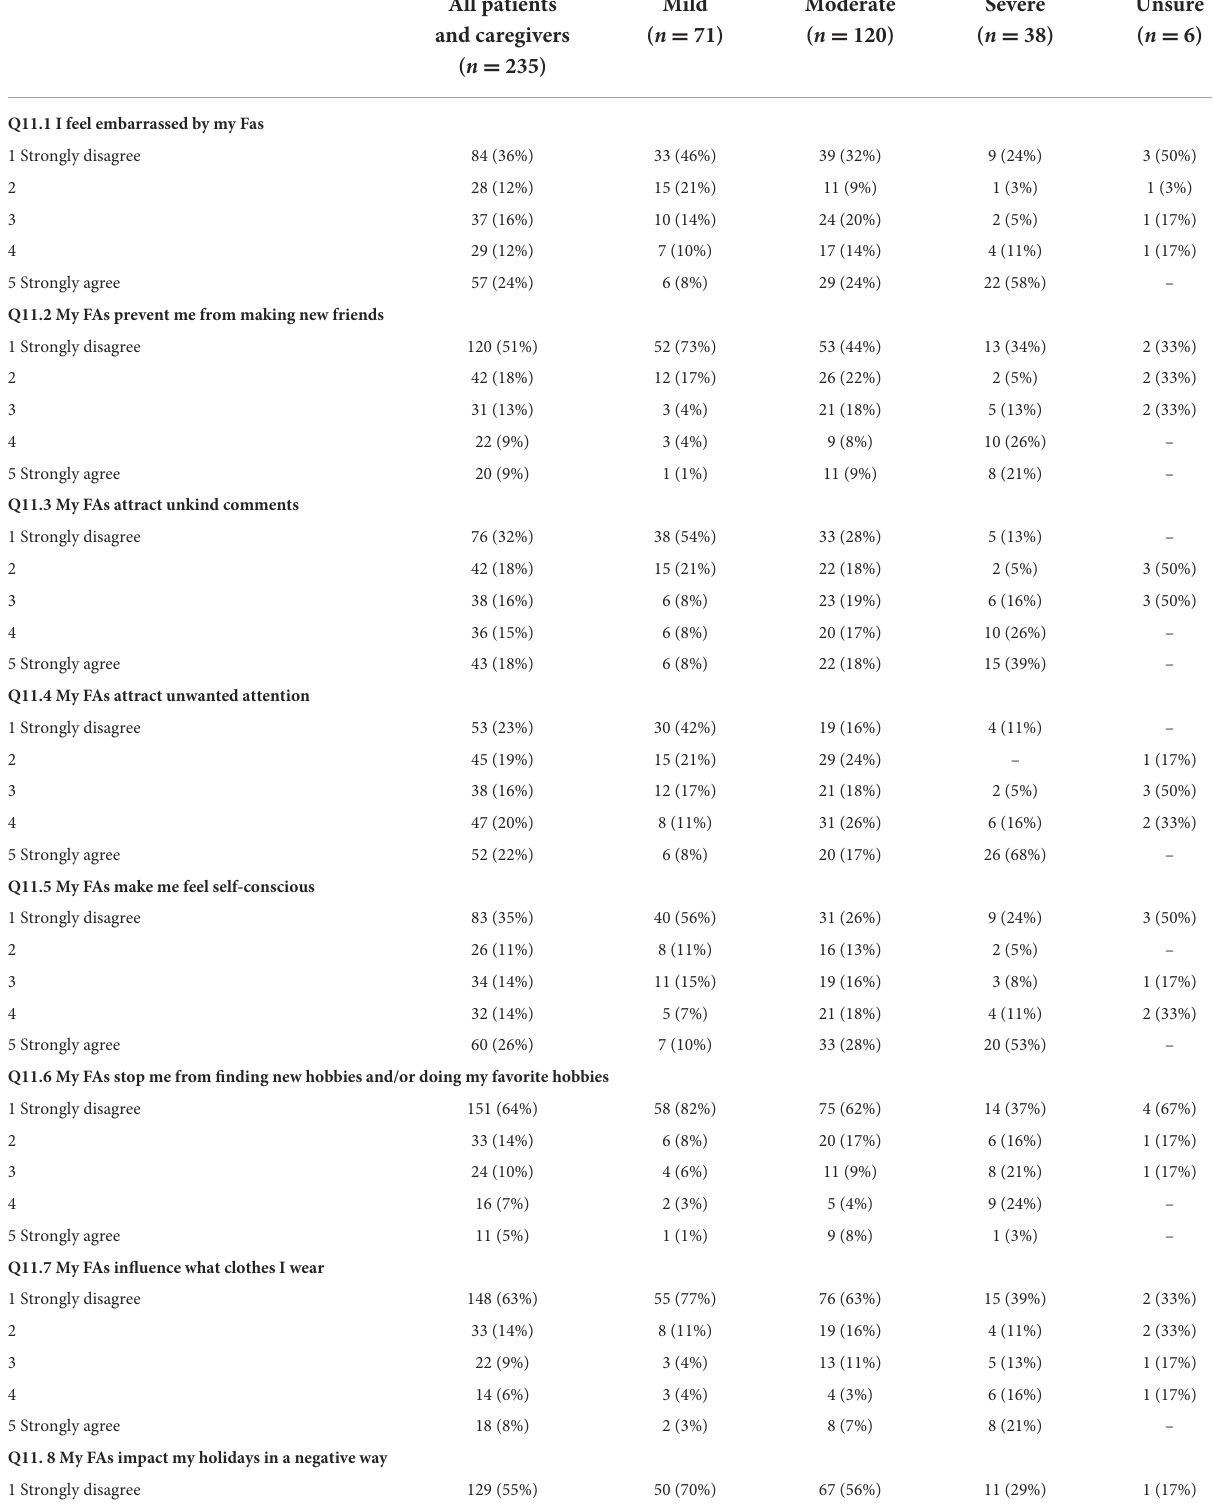
TABLE 4 Psycho-social impact of FAs and impact on quality of life in each severity